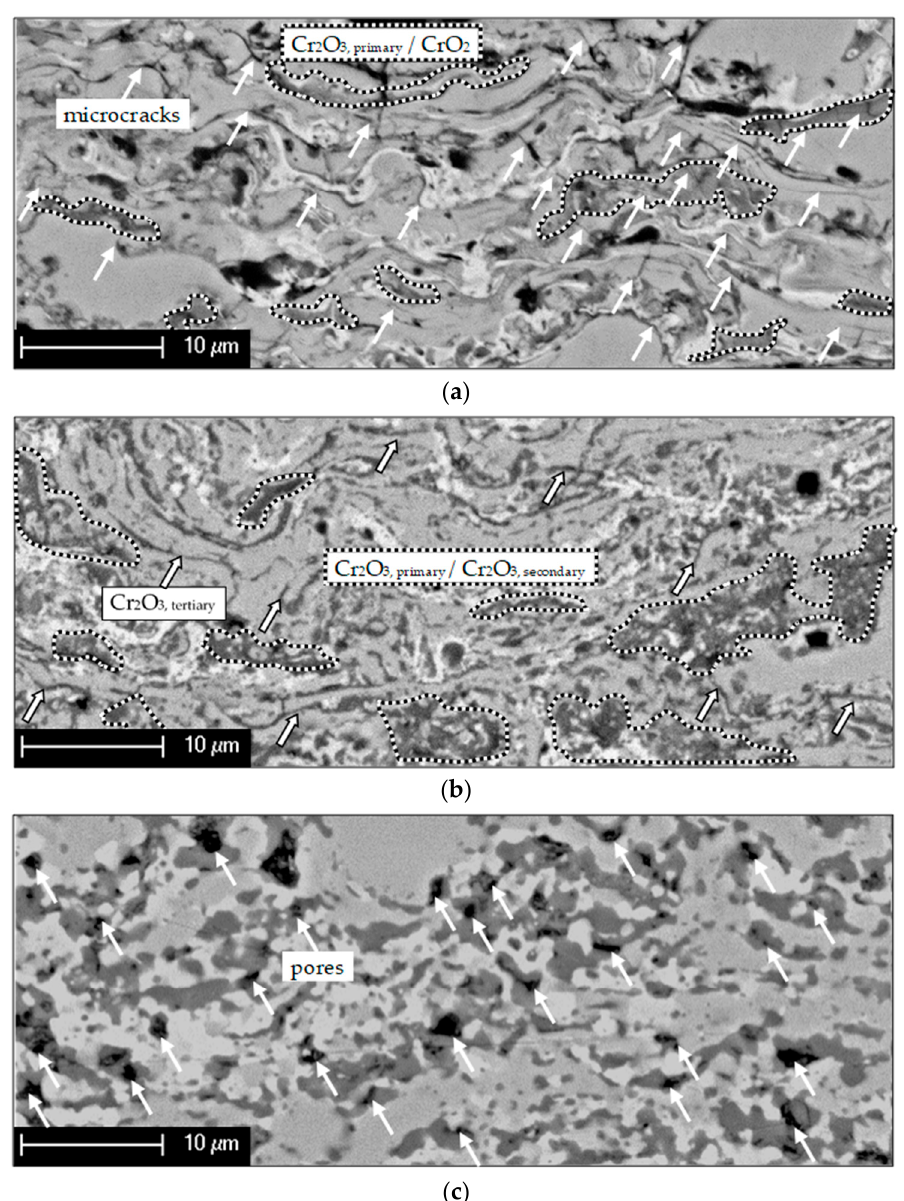
Figure 2. Alteration of Cr-Cr x O y coating microstructures exemplarily indicated in the ( a ) as-sprayed, ( b ) heat-treated (t 900 °C = 10 h), and ( c ) isothermally oxidized (t 900 °C = 1200 h) states.